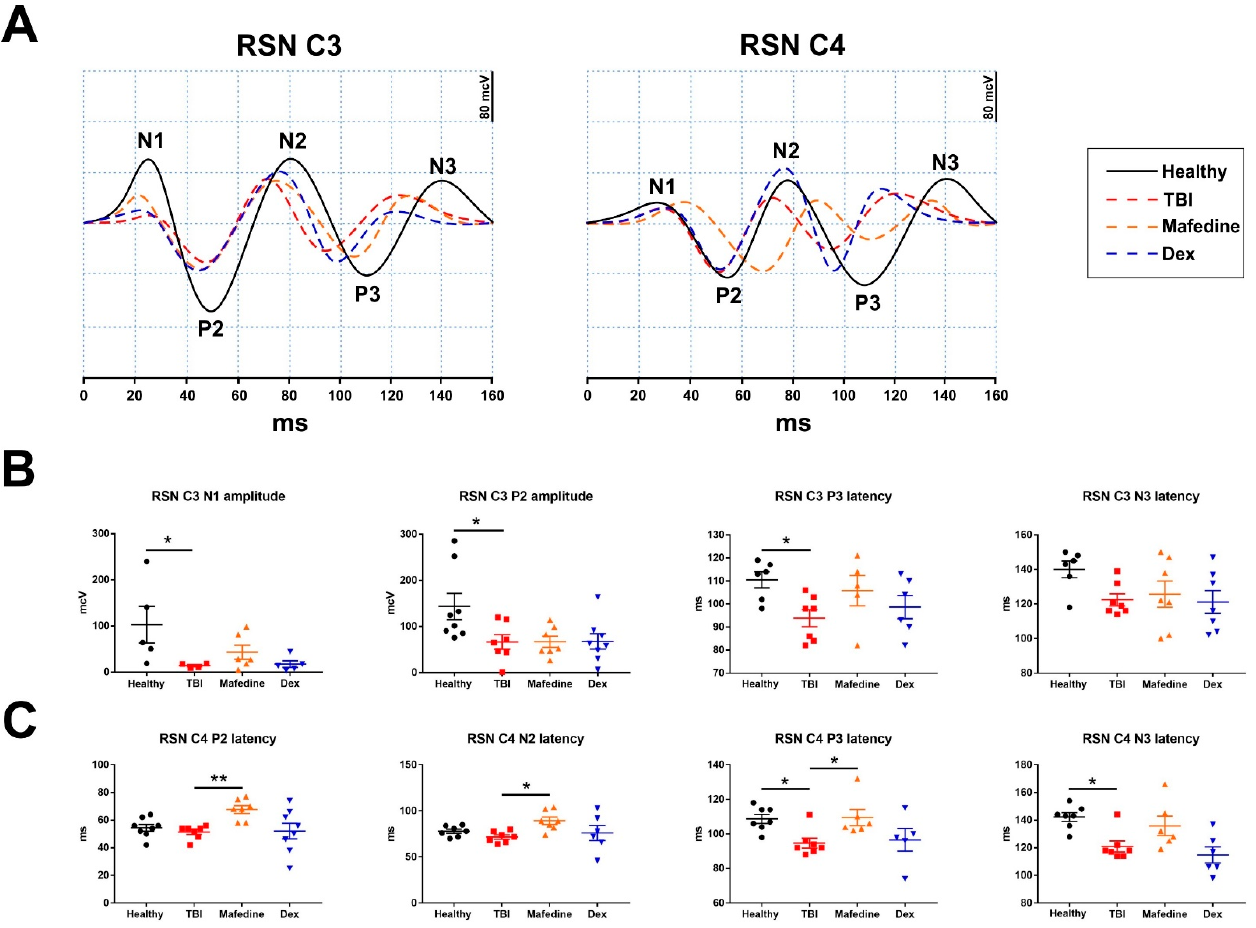
Figure 6. ( A ) averaged SSEP curves in channels C3 and C4 under right sciatic nerve (RSN) stimulation; ( B ) SSEP curve parameters in channel C3 under RSN stimulation. ( C ) SSEP curve parameters in channel C3 under right sciatic nerve stimulation. Dex—dexmedetomidine; * p < 0.05, ** p <0.01 vs. TBI. Table 2. Mean corticographic signal amplitudes ( μ V) in channels FP1, FP2, C3, C4, O1, and O2 at post-TBI days 3 and 7. Channel